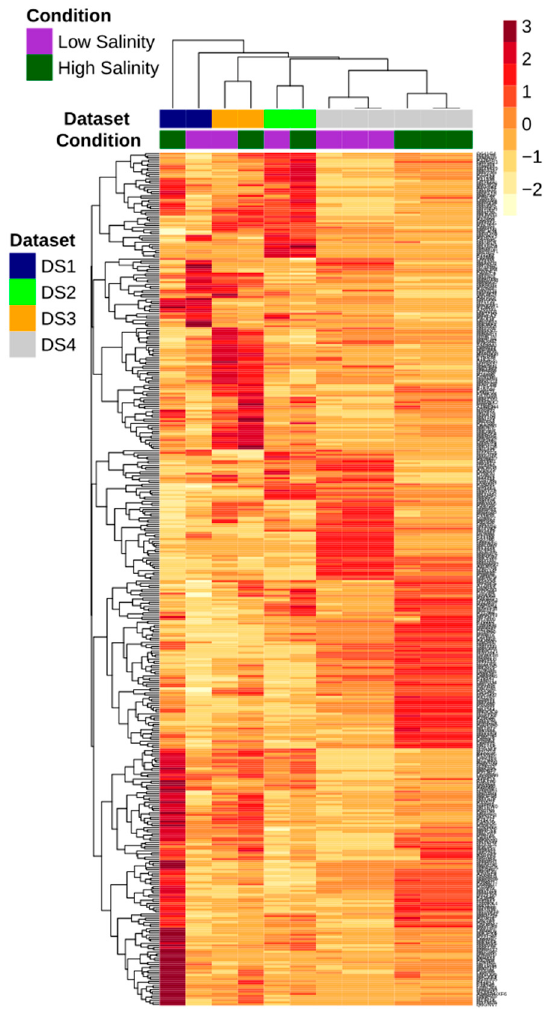
Figure 2. Heatmap showing differentially expressed transcripts identified by meta-analysis in the gills transcriptome of four different Chinese mitten crab (CMC) datasets under salinity. Only transcripts with an average fold change (FC) of ≥ 2.0 and a Benjamini-Hochberg adjusted p -value of <0.05 were considered to be differentially expressed.